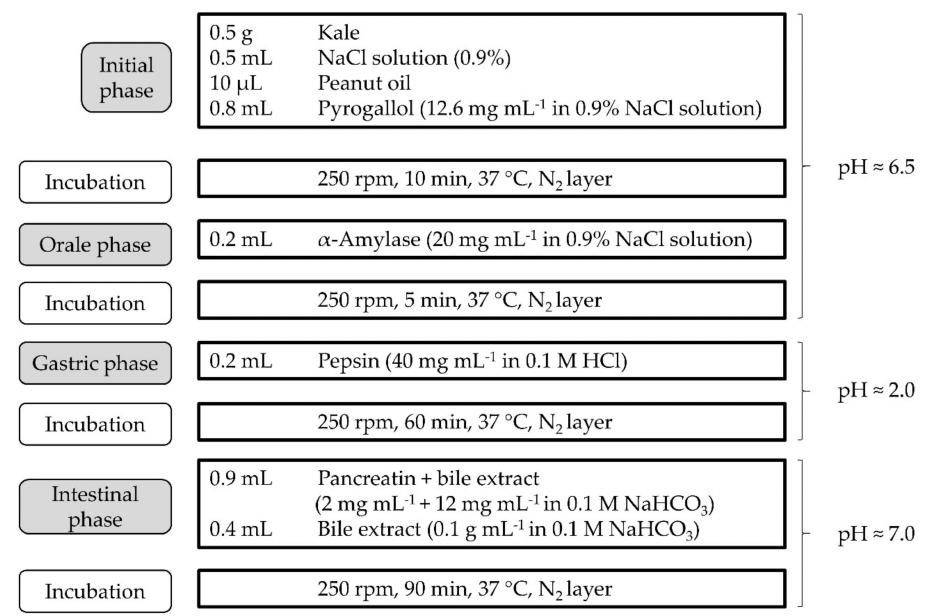
Figure 1. In vitro digestion procedure for determination of bioaccessibility of carotenoids in kale